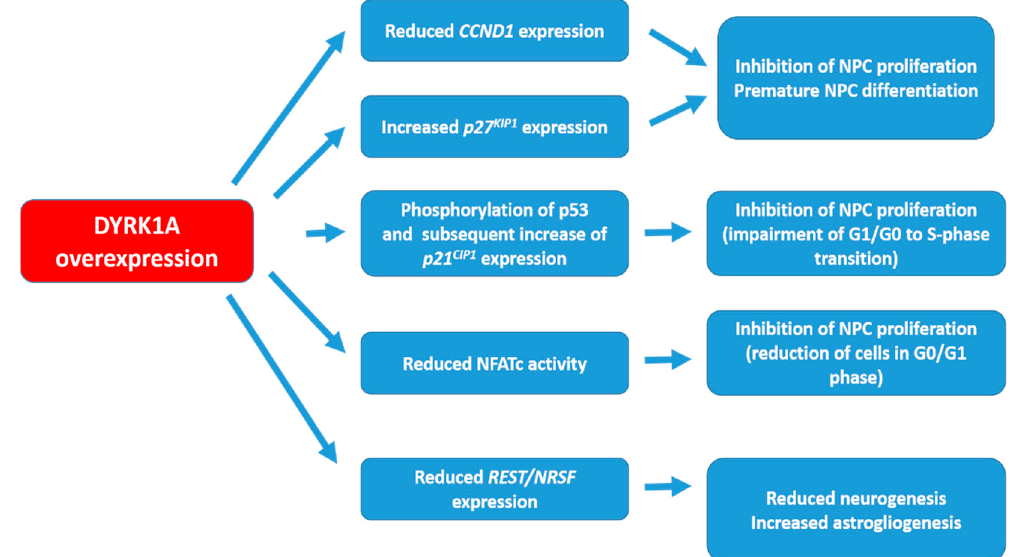
Figure 1. DYRK1A targets and the possible mechanisms underlying neurogenesis impairment in Down syndrome. See text for explanation. CCND1: cyclin D1; NFATc: Nuclear factor of activated T cell cytoplasmic; NPC: neuroprogenitor cell; REST/NRSF: Repressor element-1 binding transcription factor or neuron-restrictive silencer factor.